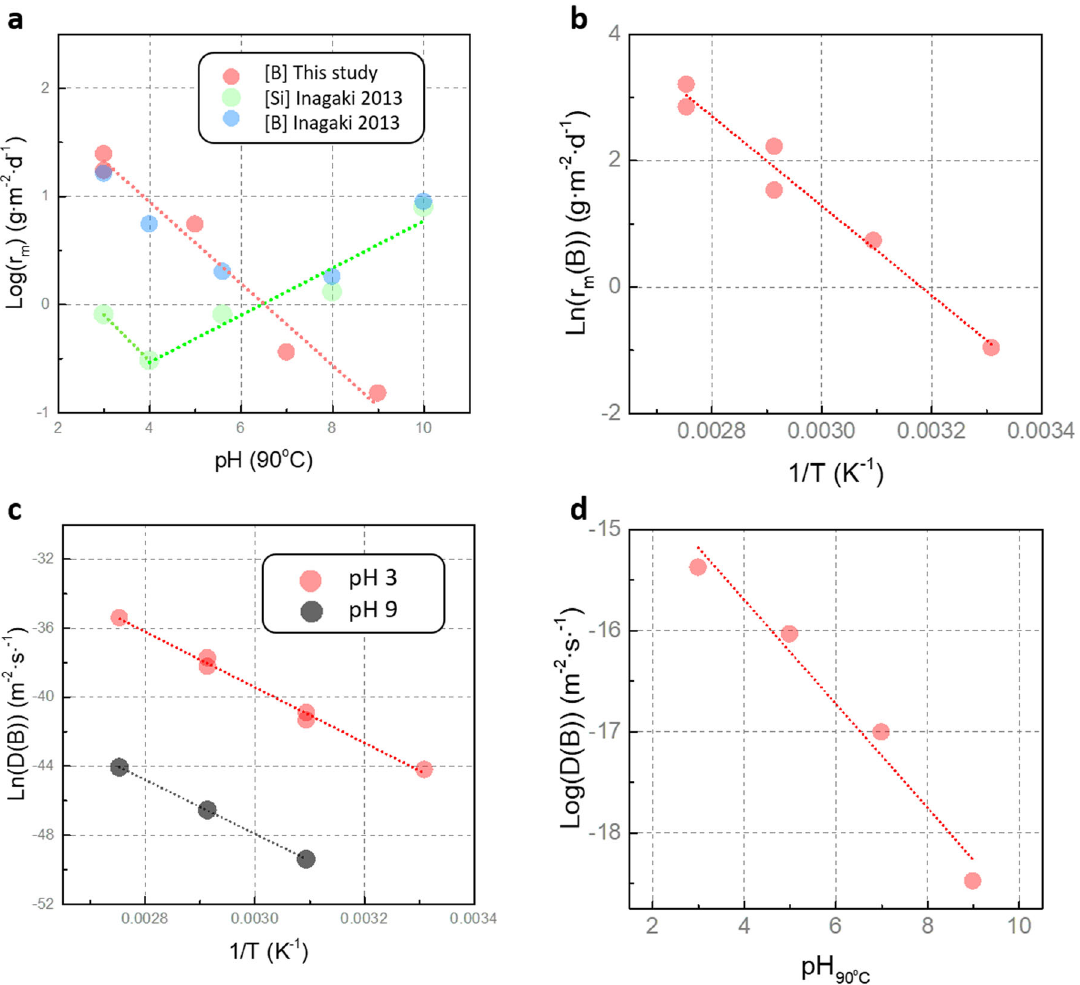
Fig. 5 pH and temperature effects on B release rate in Si-saturated solutions. a B dissolution rate in silica saturated solutions (red symbols) compared to literature data obtained far from saturation, i.e., in extremely dilute solutions (C(Si) <1 mg·L − 1 ). Green (Si) and blue symbols (B) correspond to the so-called initial or forward dissolution rate, determined far from saturation. b Arrhenius plot for maximum dissolution rate of B, r m (B), from experiments conducted at pH 3 in Si-saturated solutions. c Arrhenius plot for diffusion coef fi cient of B, D(B), from experiments conducted in Si-saturated solutions at pH 3 and pH 9. d) Apparent diffusion coef fi cient of B, D (B), as a function of pH 90°C from experiments conducted at 90 °C in Si-saturated